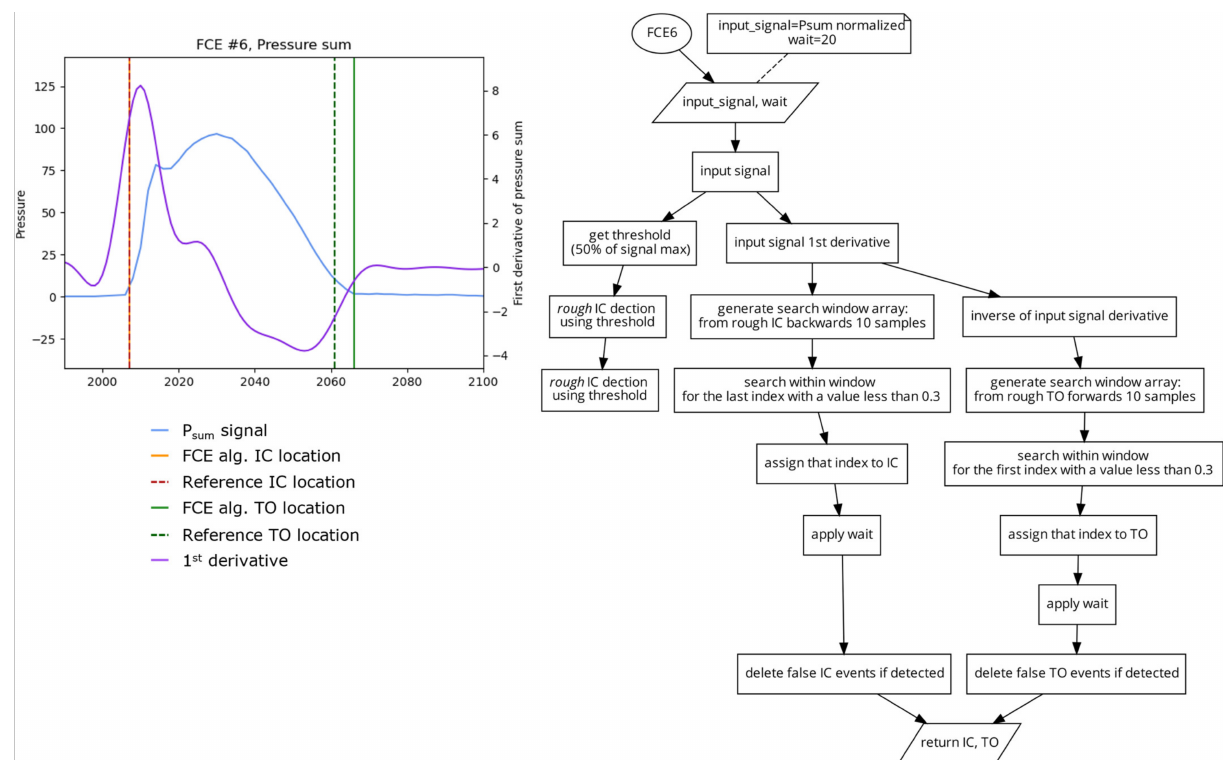
Figure 9. Plot ( left ) displaying a single stride and the location of the reference FCEs (dashed vertical) and the FCEs (solid vertical), as determined by the FCE6 algorithm ( right ).